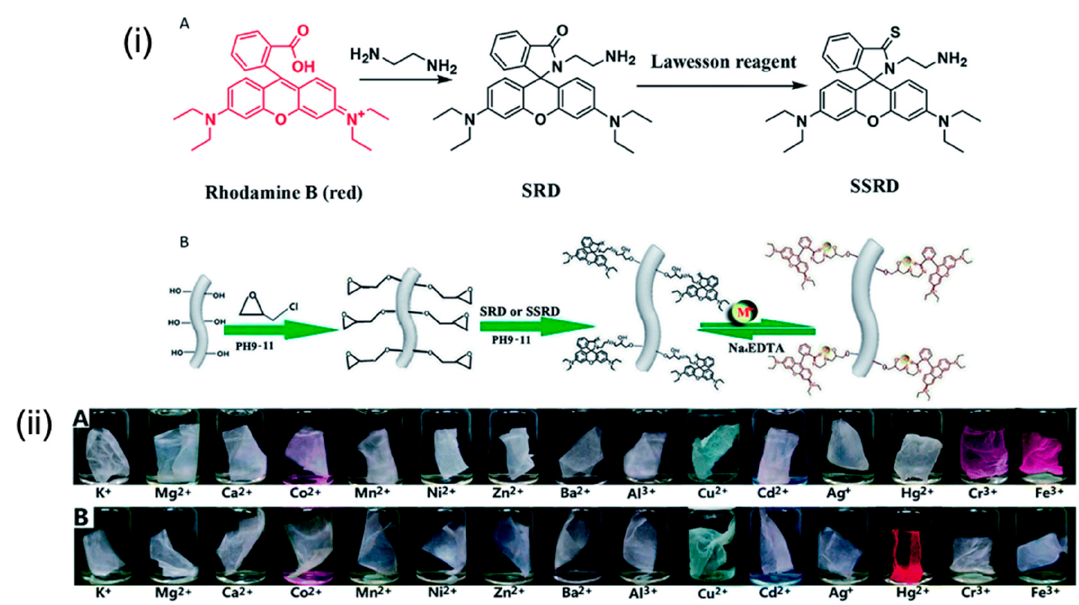
Figure 7. ( i ) Synthetic route of SRD and SSRD. ( A ) Schematic illustration of the functionalization of a poly(vinyl alcohol) electrospun nanofiber membrane by SRD (X = O, M n + = Fe 3 + or Cr 3 + ) or SSRD (X = S, M n + = Hg 2 + ) and metal detection / adsorption applications ( B ). ( ii ) Photographs of the PVANF–SRD membrane ( A ) and PVANF–SSRD membrane ( B ) immersed into K + , Mg 2 + , Ca 2 + , Co 2 + , Mn 2 + , Ni 2 + , Zn 2 + , Ba 2 + , Al 3 + , Cu 2 + , Cd 2 + , Ag + , Hg 2 + , Cr 3 + , and Fe 3 + aqueous solutions (1.0 × 10 − 3 M) for 5 min. Reprinted with permission from [50]. Copyright 2014, The Royal Society of Chemistry.